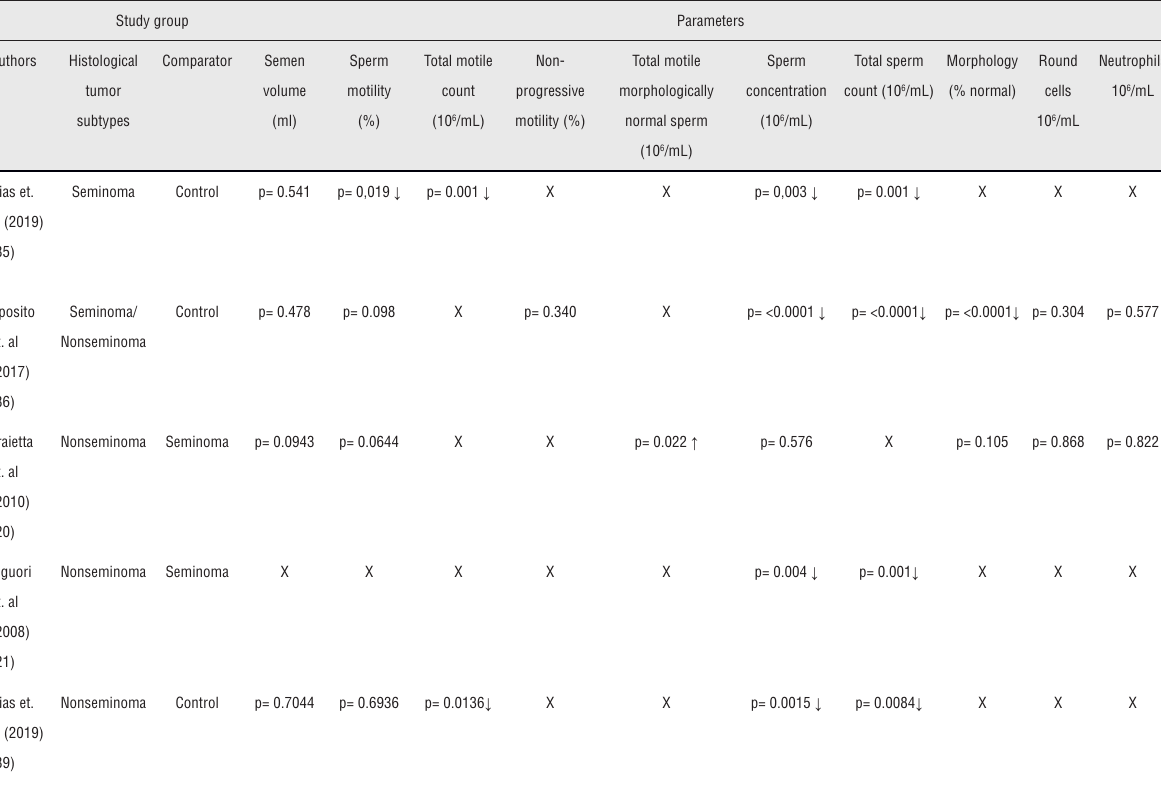
Table 1 - Studies with seminal parameters analysis according the histological tumor types seminoma and nonseminoma. Study